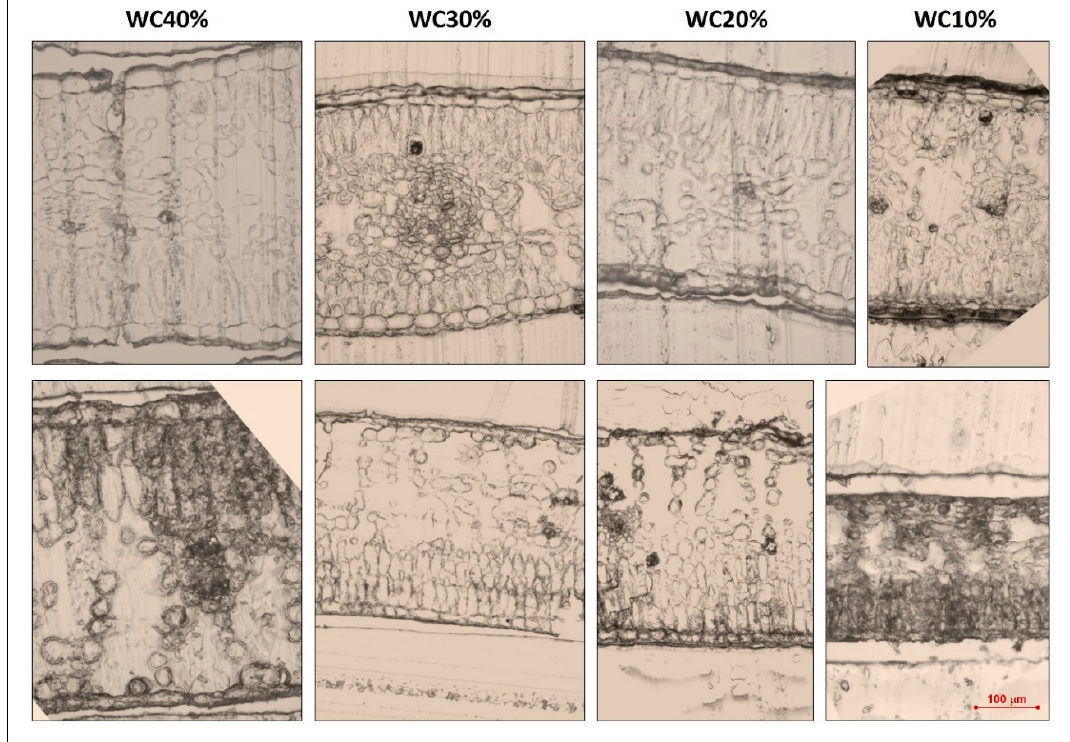
Figure 1. Light microscopy of blade cross-sections in Polygala (above) and Viburnum (below) at different water regimes (source: Toscano et al., unpublished data).